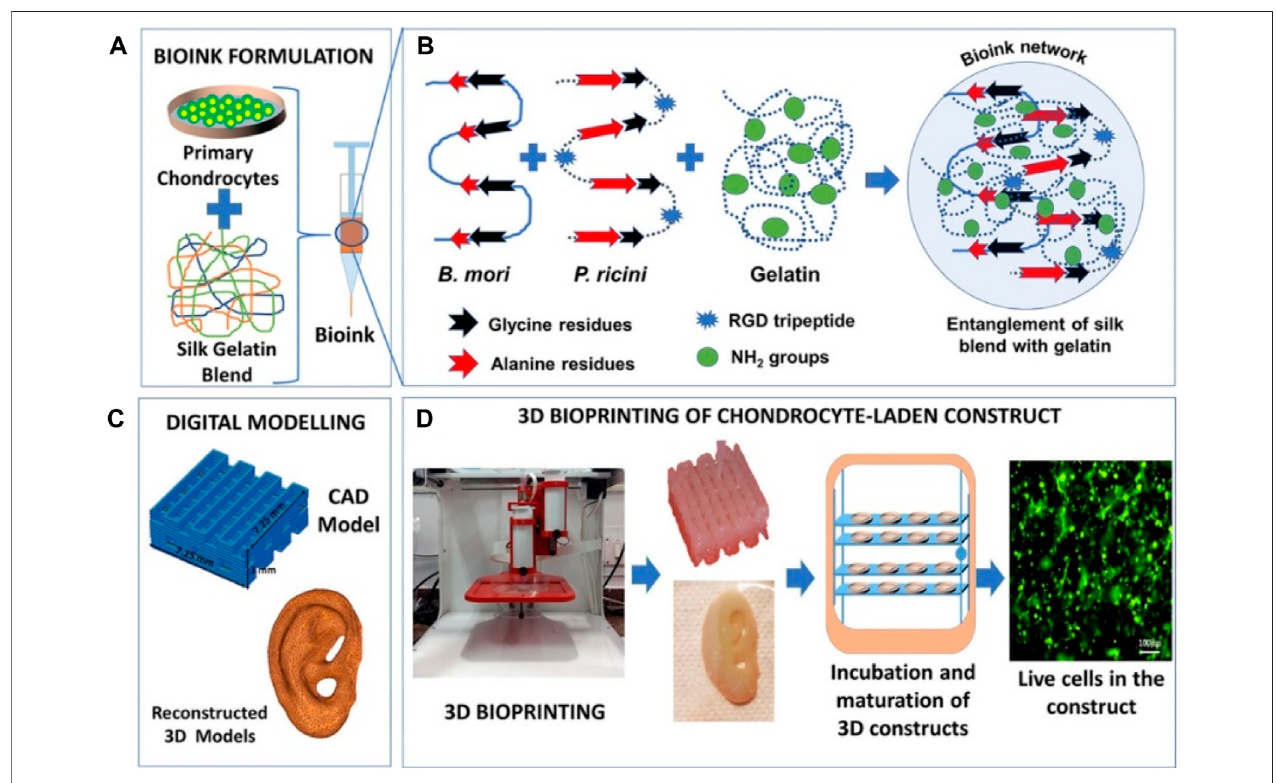
FIGURE 7 | Schematic representation of (A) bio-ink formulation, (B) polymer entanglement and interaction, (C) digital modeling, and (D) 3D bioprinting and maturation of cell-laden construct. Reproduced from Singh et al., (2019) with permission from Copyright 2019 American Chemical Society.